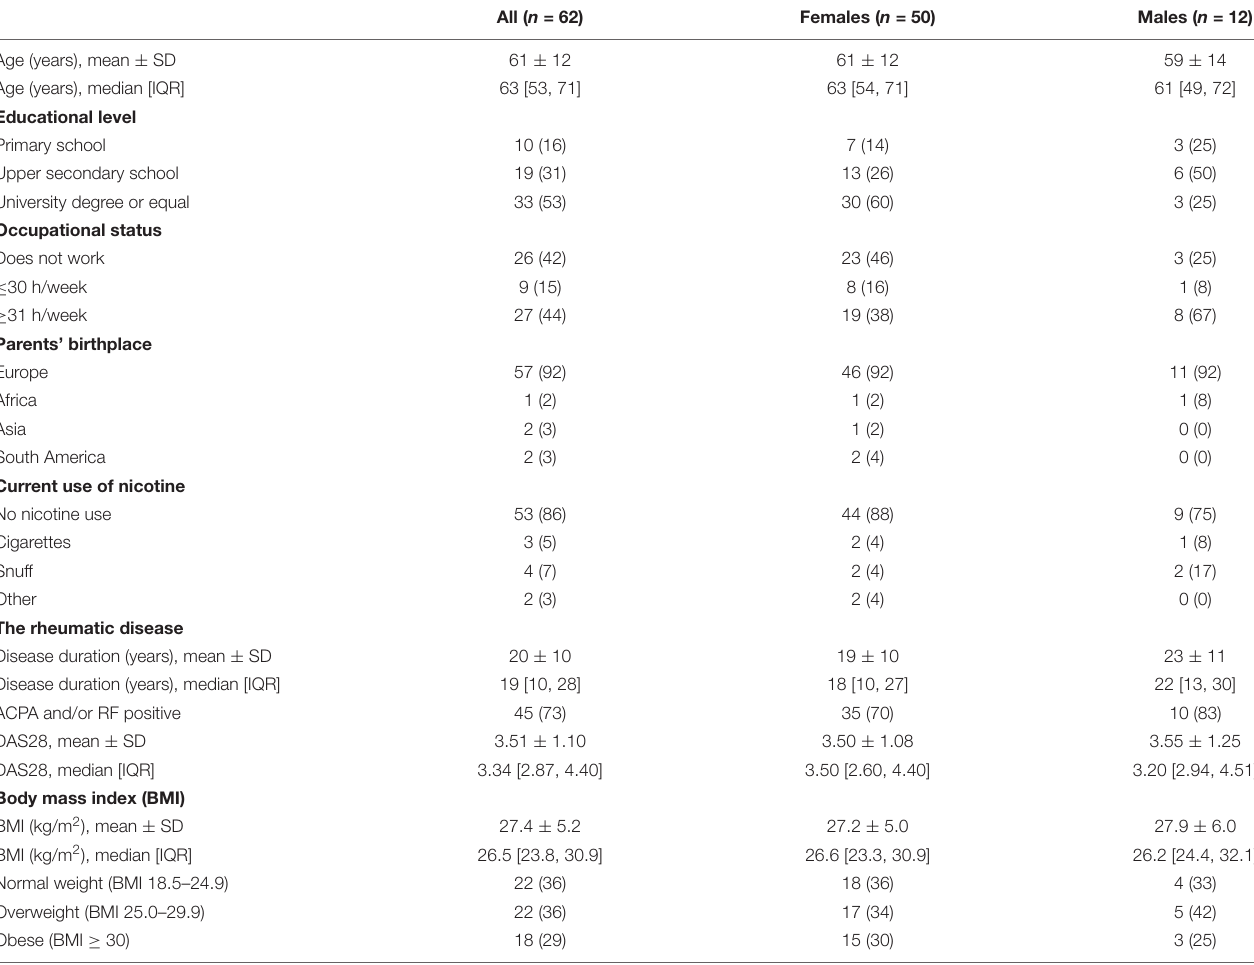
TABLE 1 | Sociodemographic characteristics of the study population, i.e., patients with rheumatoid arthritis residing in southwestern Sweden a . All ( n = 62) Females ( n = 50) Males ( n =